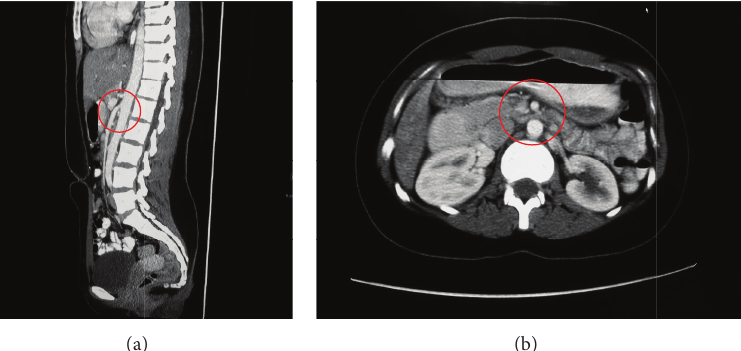
Figure 2: Narrow aortomesenteric angle (10 ∘ ) and aortomesenteric distance (6 mm) (red circles in (a) and (b), resp.), compressing the duodenum in